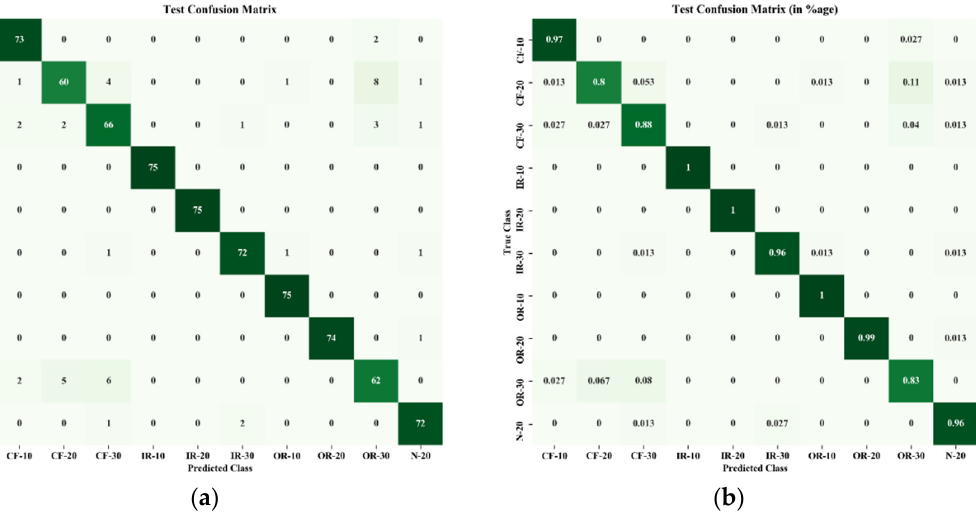
Figure 10. Confusion matrix of testing data: ( a ) in terms of number of testing data points; ( b ) in terms of percentage (%). Table 3. Classification report of PSO-SVM